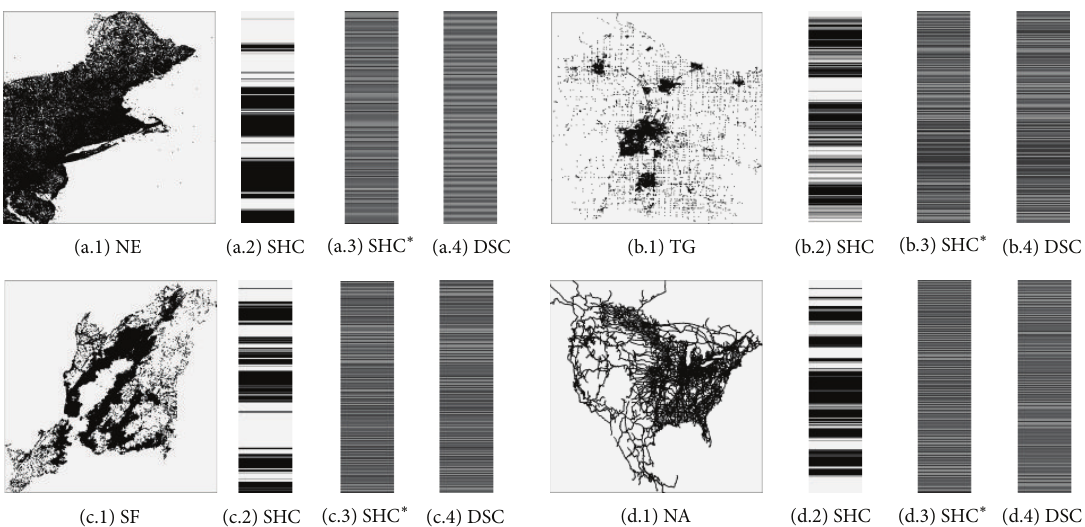
Figure 7: Visualization of POIs’ indexes built by SHC, SHC ∗ , and DSC.